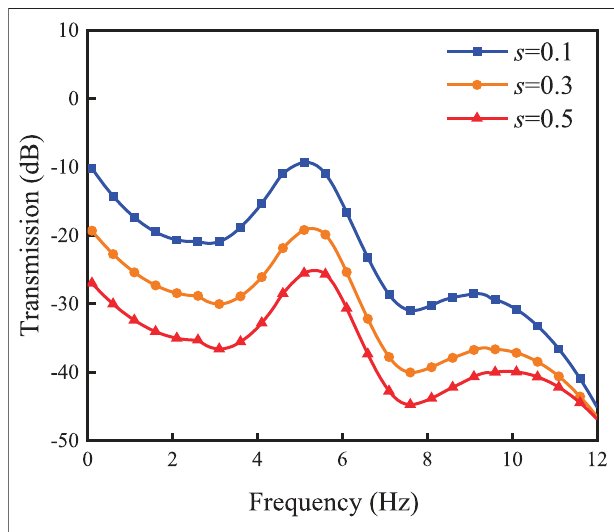
FIGURE 15 | Transmission spectrum of LRSM under the in fl uence of different scale factor s